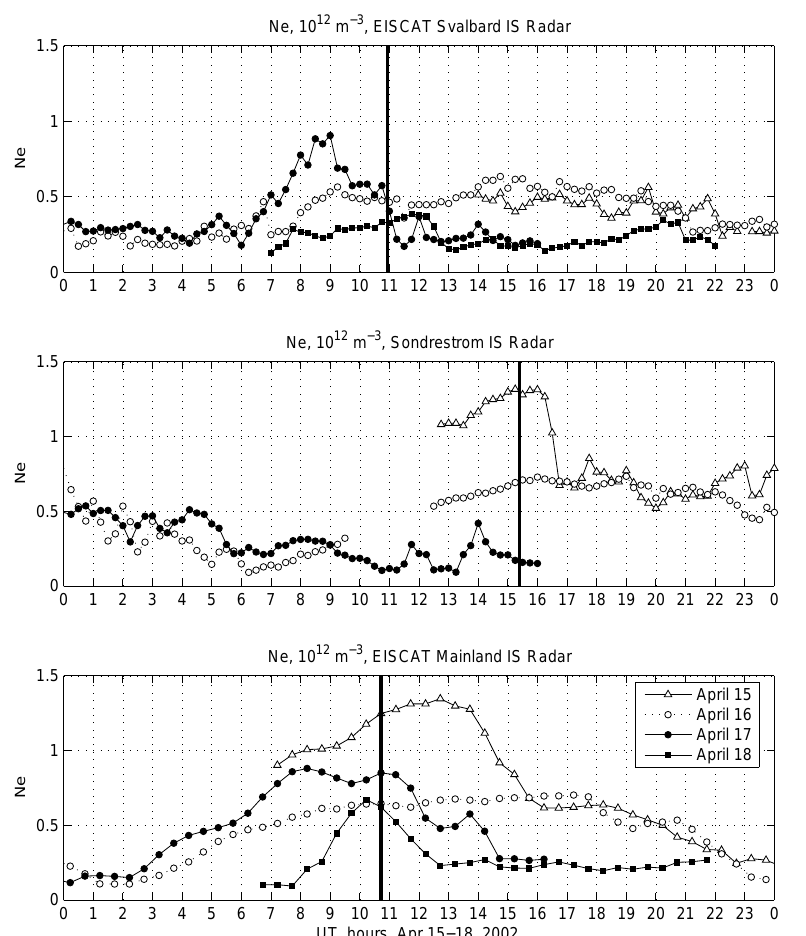
Fig. 5. Electron density at 350km measured by Svalbard ISR (top), Sondrestrom ISR (middle), and EISCAT Mainland ISR (bottom). Vertical lines show local noon for each